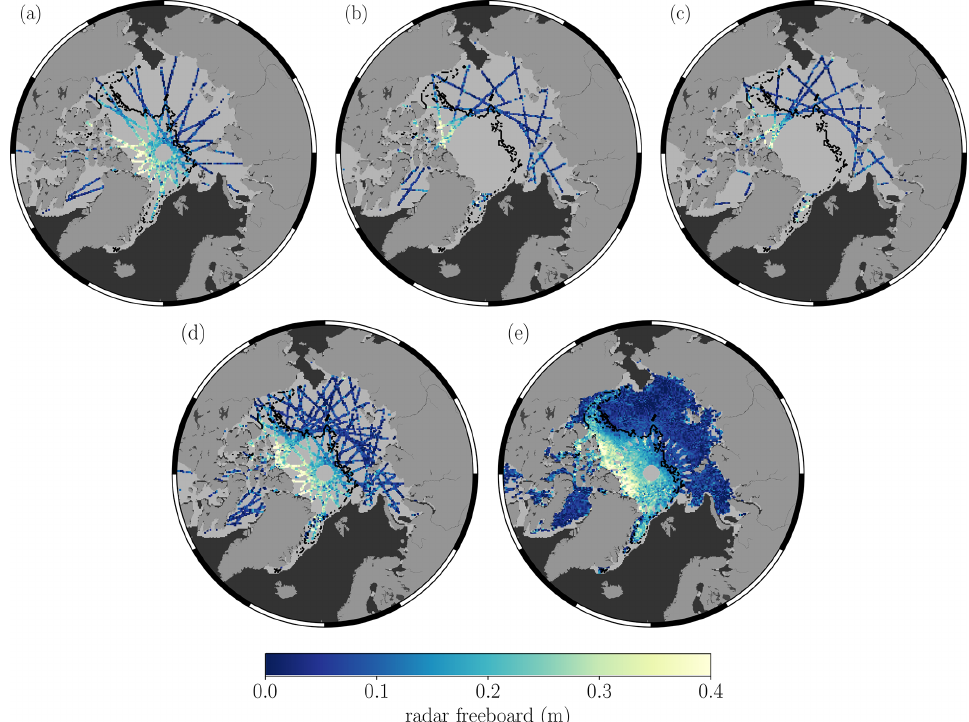
Figure 1. Gridded tracks from CS2 (a) , S3A (b) , and S3B (c) on a 25 × 25km polar stereographic grid, respectively covering approximately 11%, 7%, and 7% of the total NSIDC NASA Team sea ice extent (grey mask) on day t = 1 December 2018. By combining the three satellites (d) , this coverage is increased to approximately 23%. Combining t ± 4d of gridded tracks (e) , the coverage is increased further to approximately 72% of the total sea ice extent. The black ice type contour (from OSI-SAF) shows the boundary between thick MYI and thin FYI, on day t